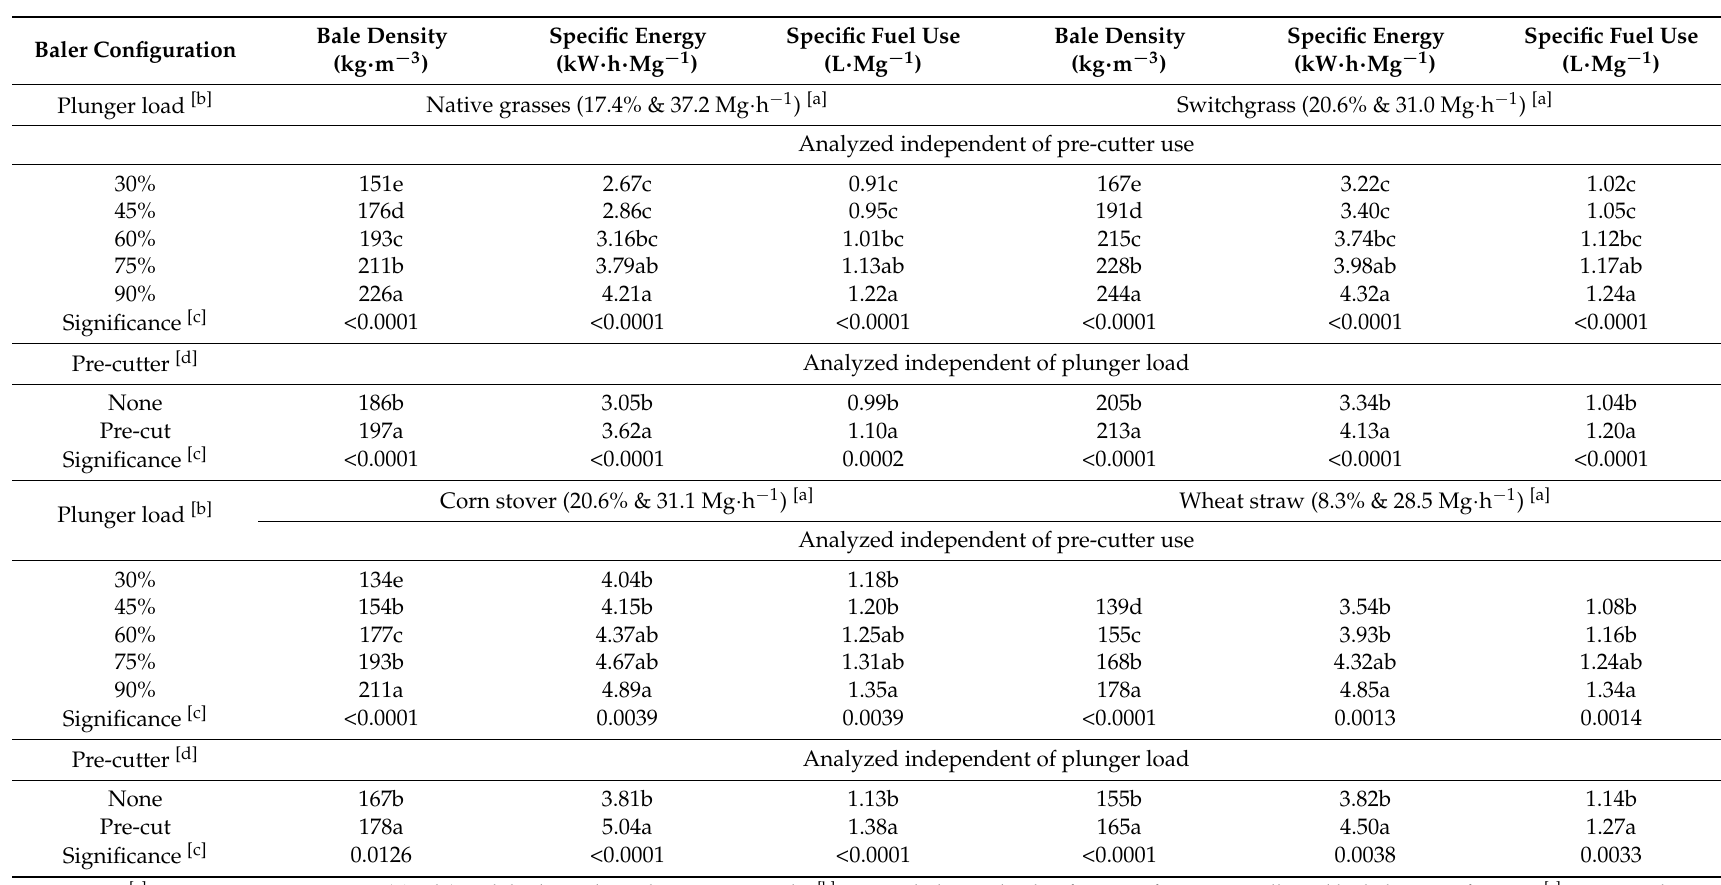
Table 4. Large square bale density and specific energy and fuel use (all on dry basis) as affected by plunger load and pre-cutting (LSBr expr. No. 3, Table 1). Baler